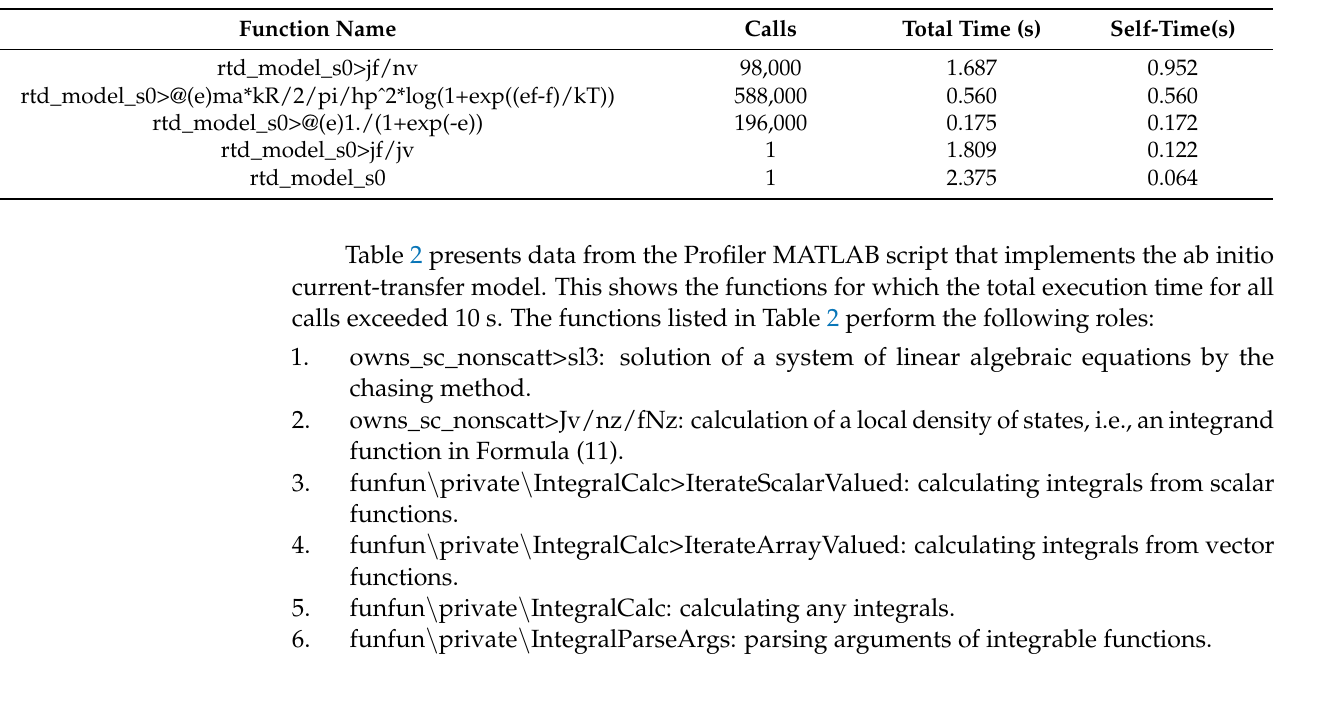
Table 3. Time taken for the calculation of current–voltage characteristics using the compact